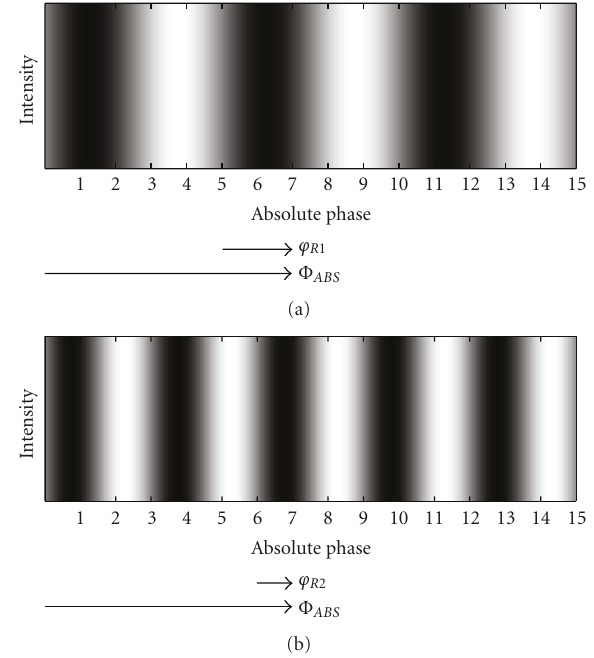
Figure 1: An example of two periodic intensity patterns and their relation to wrapped PS values.